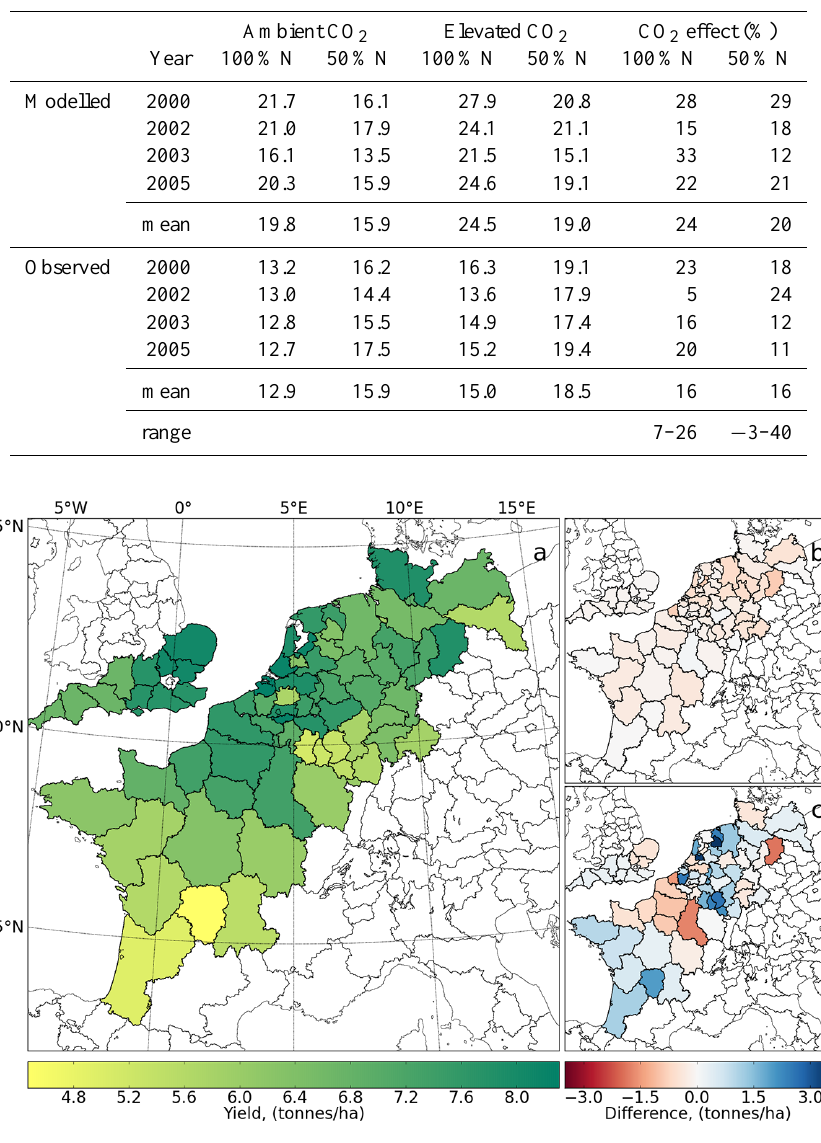
Figure 6. Reported regional yields from EUROSTAT (a) , differences between simulated and reported yields for the F opt ( T , A ) setup (b) and the F t , I (c)